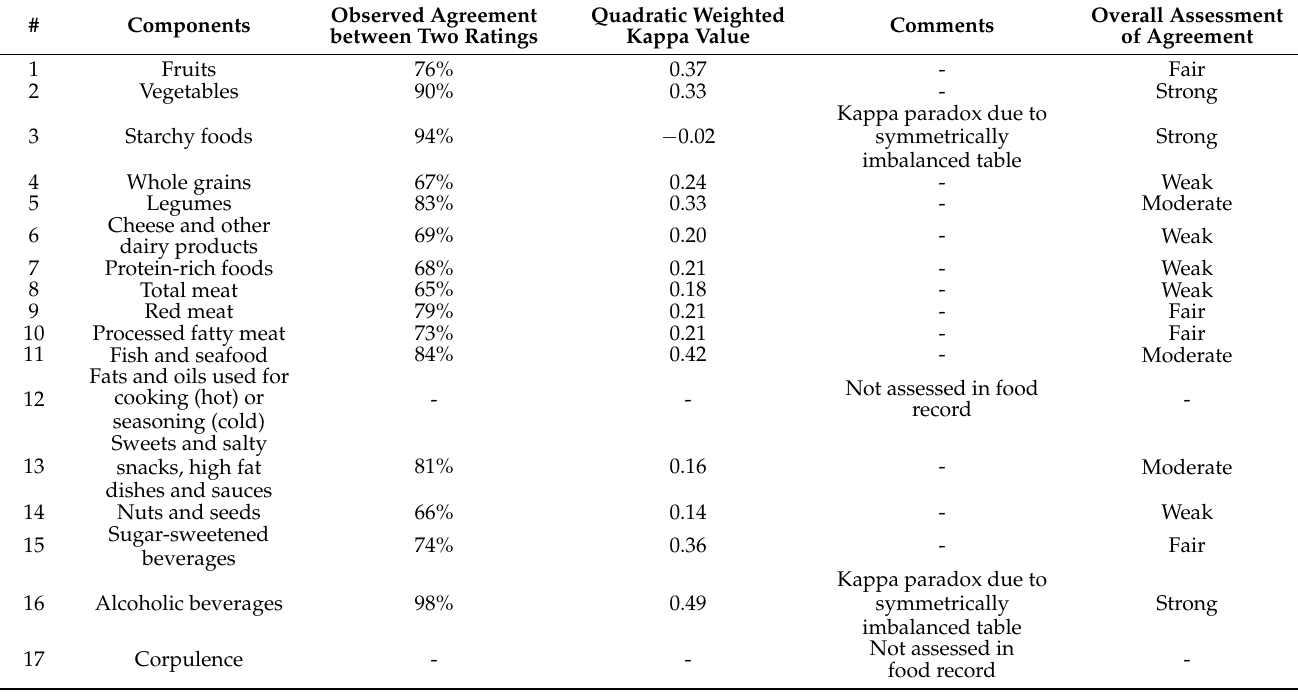
Table 2. Agreement between self-assessed and food-record based SCASA scores.